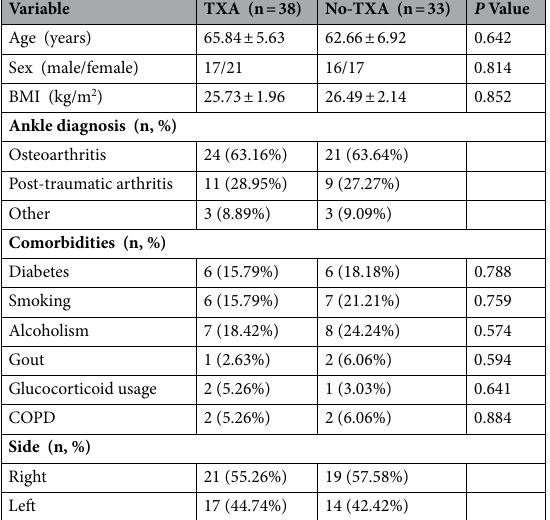
Table 1. Demographic characteristic of all patients. COPD chronic obstructive pulmonary disease.